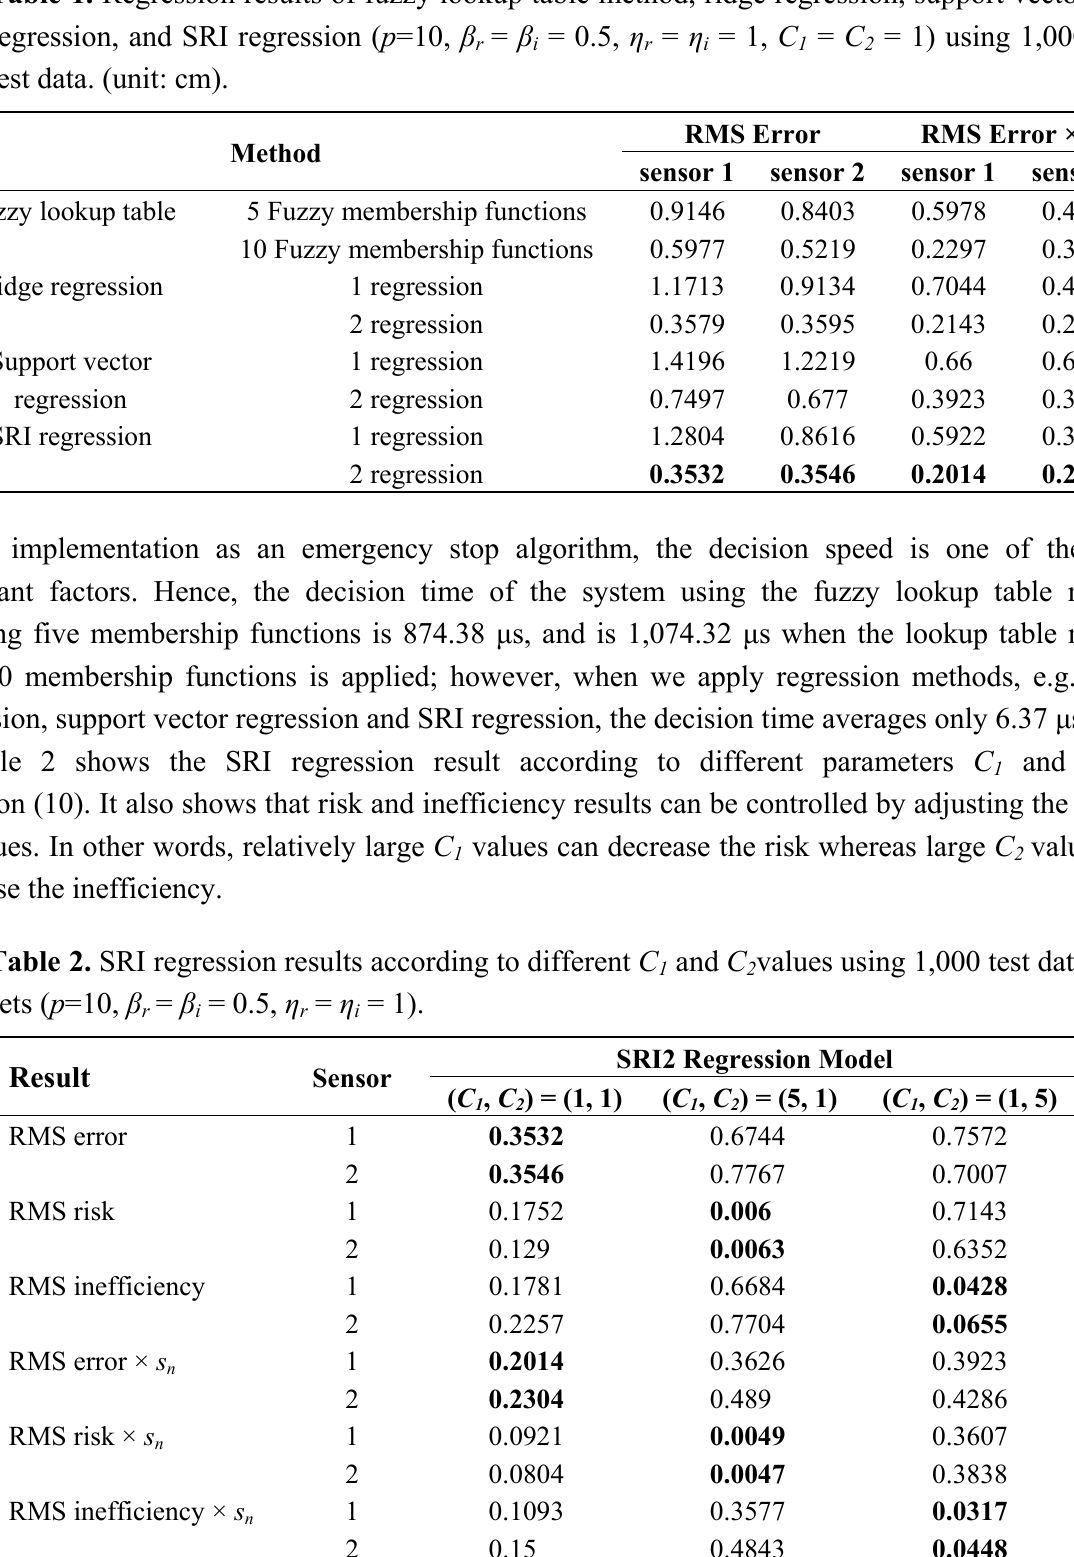
= β = 0.5, η = η = 1, C = C = 1) using 1,000 r i r i 1 2